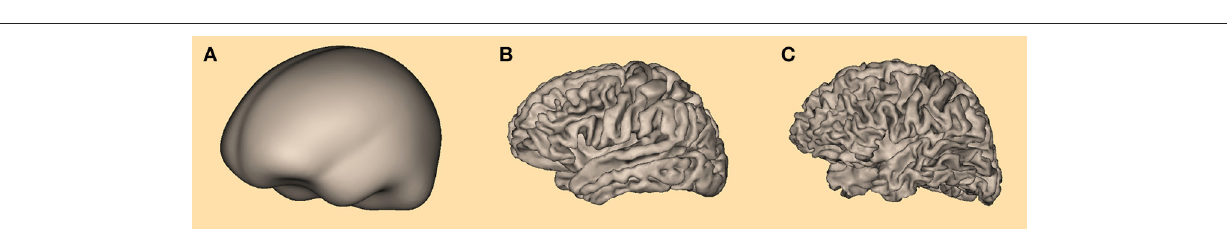
magnetic resonance imaging system (Philips Medical Systems, Gyroscan ACS-T). The resolution of the MRIs was 256 × 256 × 200 voxels, with 200 slices covering the left-to-right direction (Jordanov et al.,